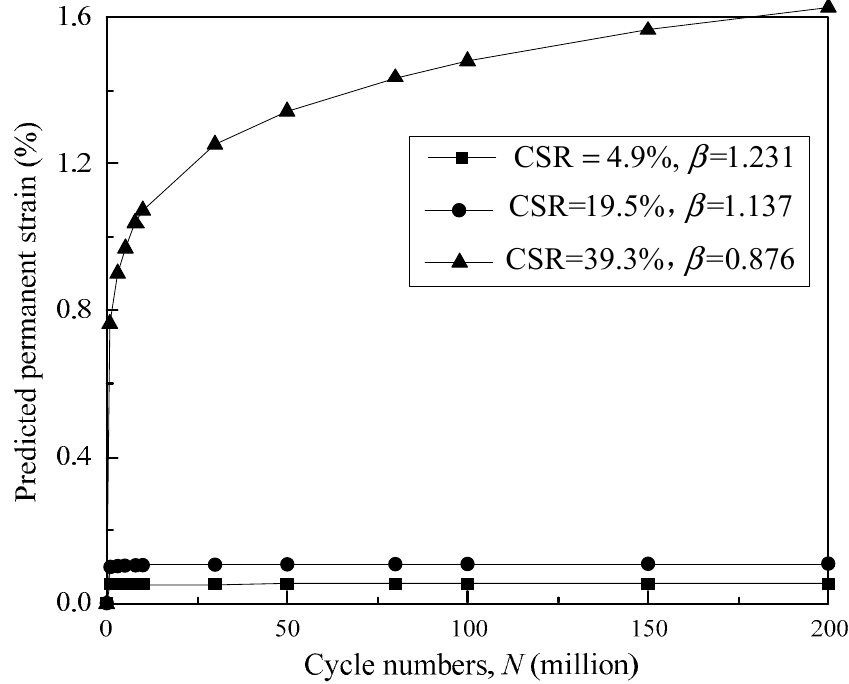
Figure 12. Predicted permanent strain at millions of loading cycles.